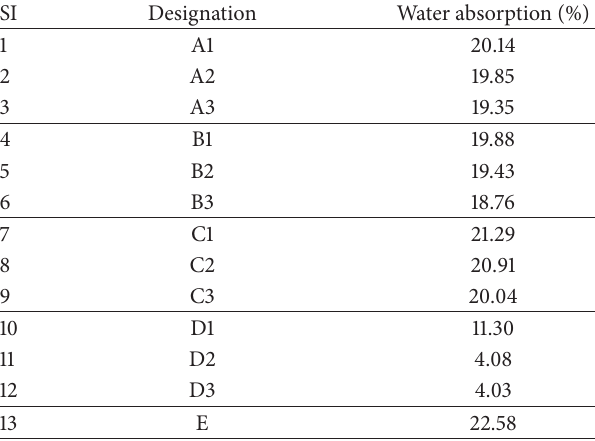
Table 5: Water absorption of pretreated and untreated OPS aggre-